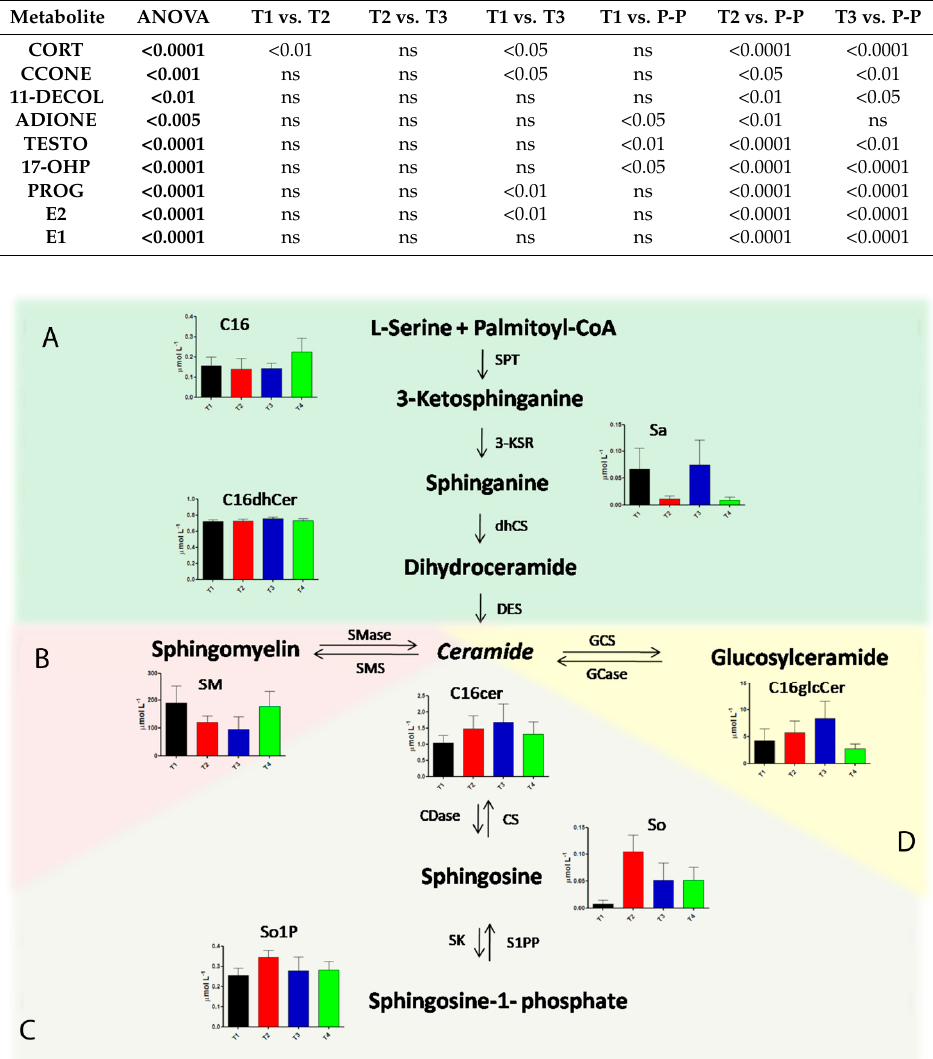
Figure 3. Sphingolipid metabolic pathways and concentration levels of the related metabolites in each of the three trimesters of pregnancy and post partum as follow: black bars for the first trimester of pregnancy, red bars for the second trimester of pregnancy, blue bars for the third trimester of pregnancy, and green bars for the post-partum period. The de novo synthesis pathway is reported in Panel ( A ), the sphingomyelin pathway is represented in Panel ( B ), the catabolic pathway is schematized in Panel ( C ), and glucosylceramide synthesis is summarized in Panel ( D ). SPT: